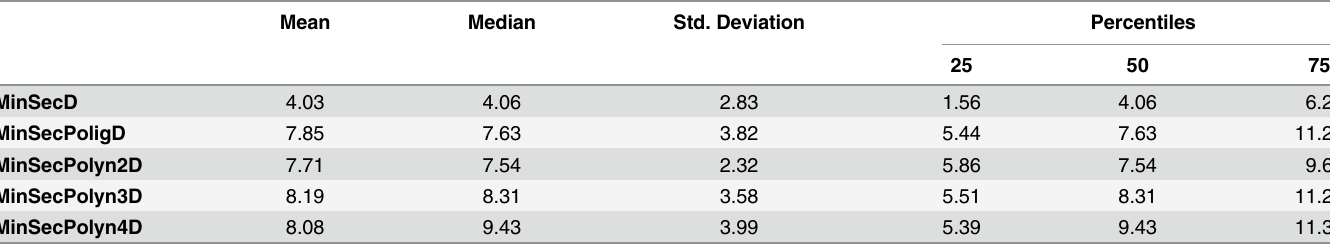
Table 5. Descriptive data for depth of minimum NLC sectional